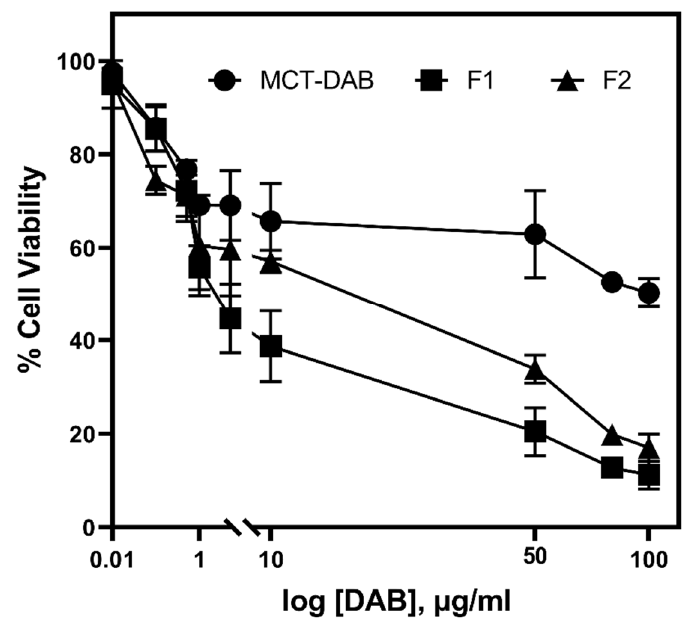
Figure 5. Cytotoxic effect of DAB on the B16BL6 cell line. Cells were incubated with various concentrations for 24 h. All data are expressed as mean percentages to untreated control cells (n = 3).